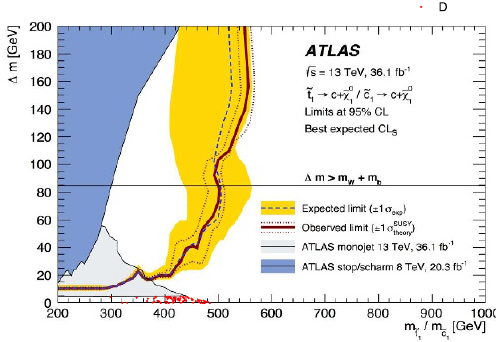
Figure 4 . Layered illustration of the by the small red points) superimposed upon the ATLAS exclusion curve plot in the charm jets plus zero lepton (0L) search region for the channel exclusion plot also includes the monojet search region of ref. [39]. The branching fraction